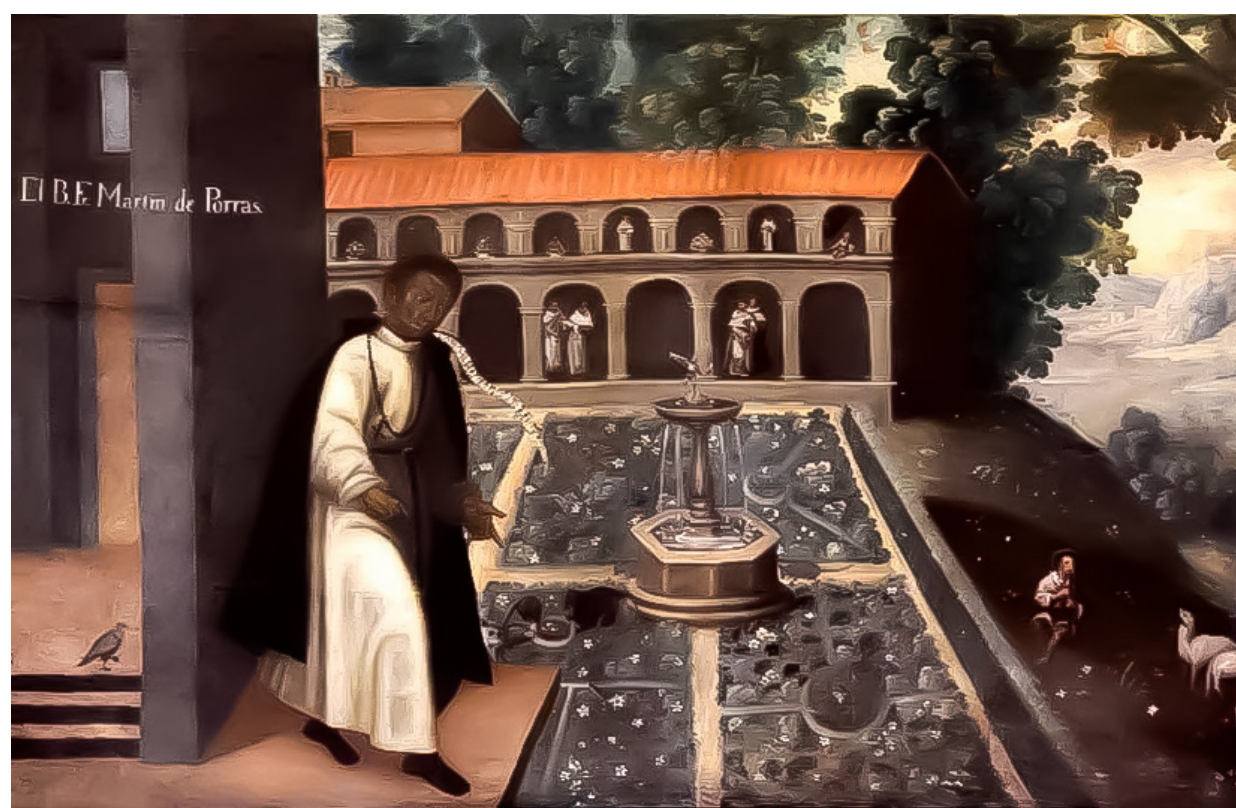
Figure 11. Unidentified artist, Saint Martin de Porres. Feeding dog, cat, and mouse miracle , 17th century, oil on canvas. Monasterio de Santa Catalina, Cuzco. Credit line: Pedro Gjurinovic Canevaro, Iconografía de San Martin de Porres , 2012.